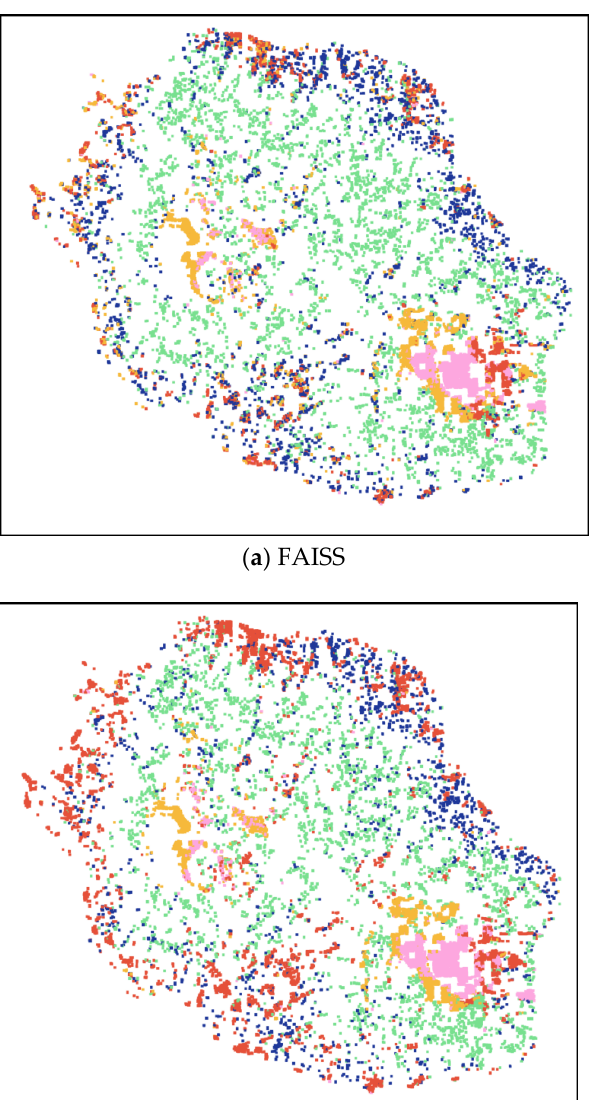
Figure 6. Quantity and percentage of each class on the Reunion Island Dataset using different meth- ods implemented with random initial cluster centers. ( a ) FAISS; ( b ) K-means; ( c ) DTIC; ( d ) true pro- portion.